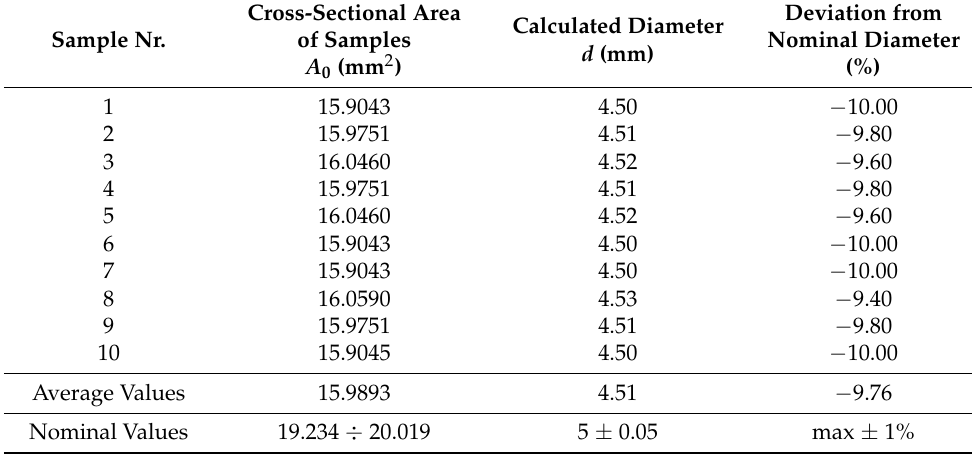
Table 1. Dimension control of samples.